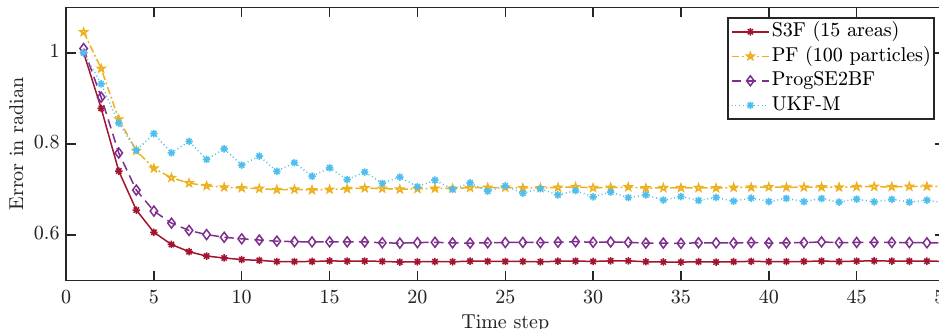
Figure 9. Average orientation errors in all time steps.